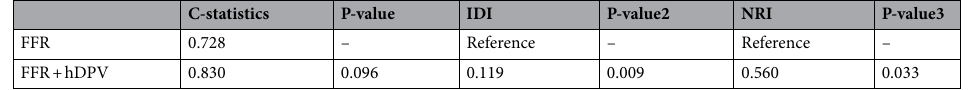
Table 4. Prediction model for a significant coronary flow increase. IDI integrated discrimination improvement, FFR fractional flow reserve, hDPV hyperemic diastolic peak velocity, NRI net reclassification